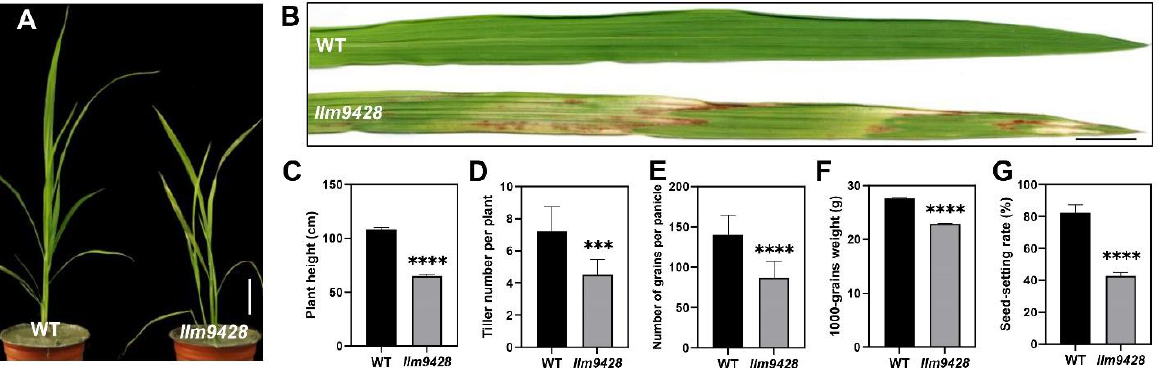
Figure 1. Phenotypic observation of wild type and llm9428. ( A ) Plant of WT and llm9428 at the seedling stage, ( B ) The phenotype of WT leaf and llm9428 leaf at the seedling stage. Comparison of plant height ( C ) tiller number per plant ( D ) number of grains per panicle ( E ) 1000-grains weight ( F ) and seed setting rate ( G ) between WT and llm9428 respectively. Statistical significance was analyzed using Student’s t -test, *** and **** indicate p < 0.001 and p < 0.0001, respectively. Scale bar in ( A , B ) =10 cm. Data presented in ( C – G ) are the average of n = 10 plants. 2.2. llm9428 Showed Decreased Cell Viability and Increased (Reactive Oxygen Species) ROS To assess the changes associated with the lesion mimic phenotype on leaves, trypan blue staining was used to check cell viability in llm9428 and the WT (Figure 2). Trypan blue solution produced light stains in the WT and dark and larger stains on leaves of llm9428 , which indicated the cell viability in llm9428 had been compromised (Figure 2A). Excessive ROS accumulation can be a result of genetic factors and environmental stresses and cause damage to the cellular machinery, proteins, DNA and structure of macromolecules [24]. Additionally, 3, 3′ -diaminobenzidine (DAB) staining revealed high levels of H 2 O 2 in llm9428 as compared to the WT (Figure 2B). These histochemical assays revealed that the lesion mimic phenotype was associated with increased cell death and ROS.